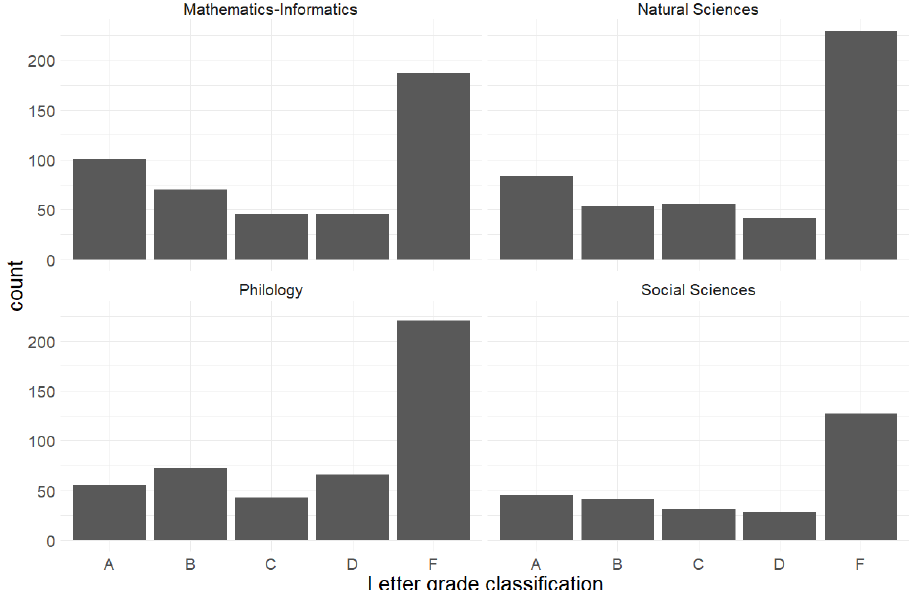
Figure 2. Counts of high schools by last admission rank-letter grade classification.